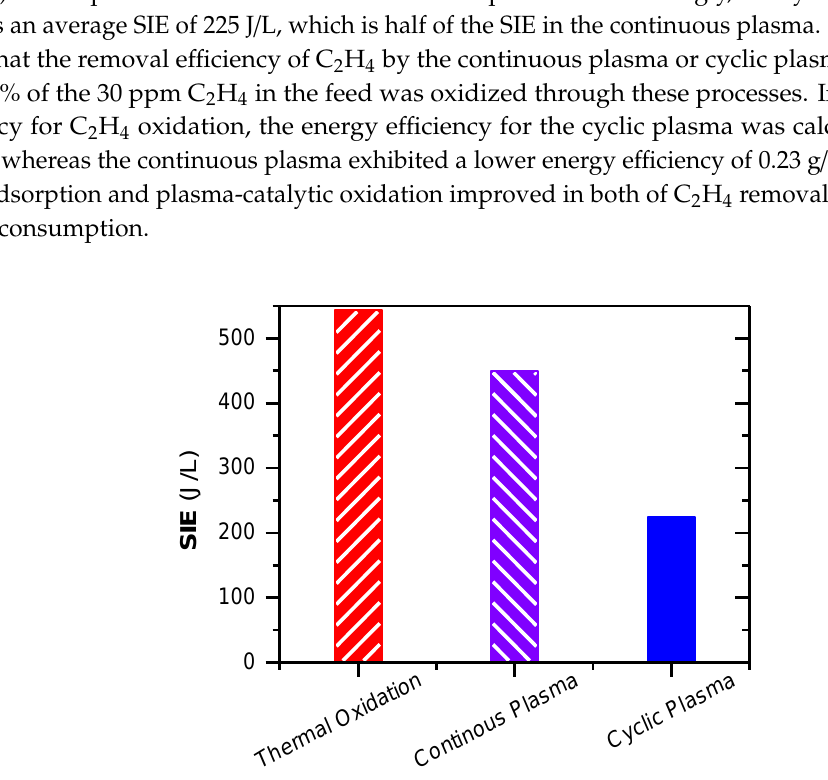
Figure 7. A comparison between continuous thermal / plasma catalyst oxidation with the cyclic adsorption and plasma-catalytic oxidation for the removal of 30 ppm C 2 H 4 at a total flow rate of 2 L / min (adsorption time: 60 min; plasma-catalytic oxidation: 30 min; consumed power for plasma discharge: 15 W).